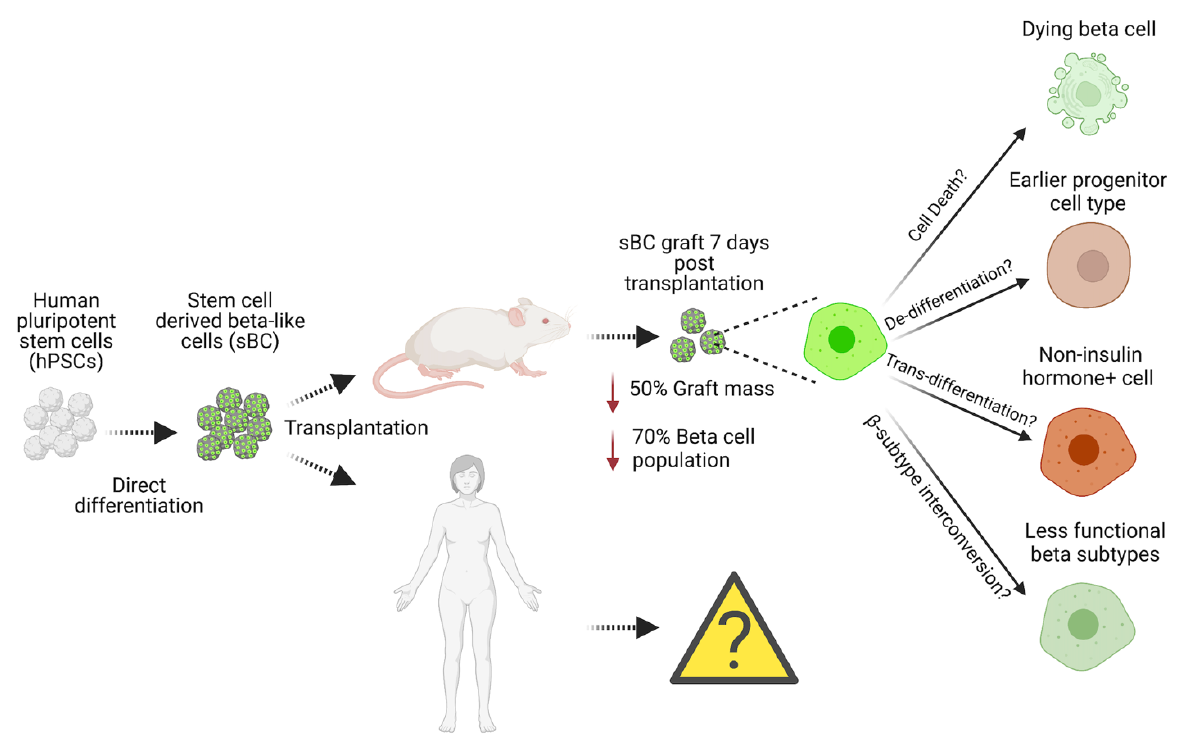
Figure 1. Reported and potential molecular and cellular mechanisms driving human pancreatic  - cell loss upon